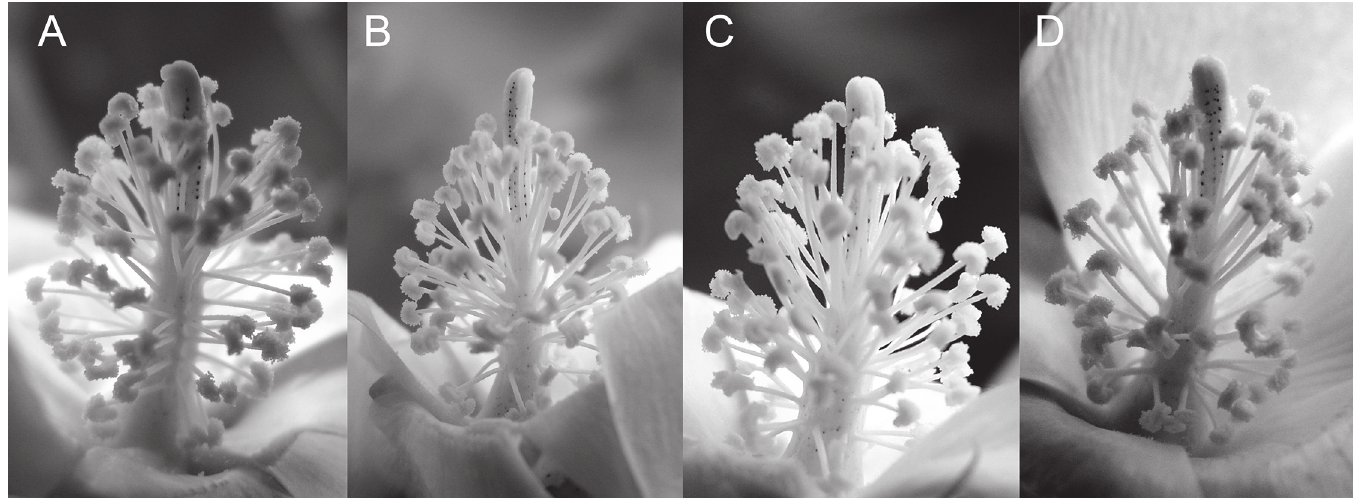
Fig 12. Photographs of anthers from high temperature grown cotton plants. (A) Line 39 [AtHSP101 minus], (B) Line 40 [AtHSP101 plus], (C) Line 52 [AtHSP101 minus], (D) Line 24 [AtHSP101 plus] flowers from plants grown under high temperatures (43°C/28°C day/night) in a greenhouse. Pollen dehiscence is apparent in all lines